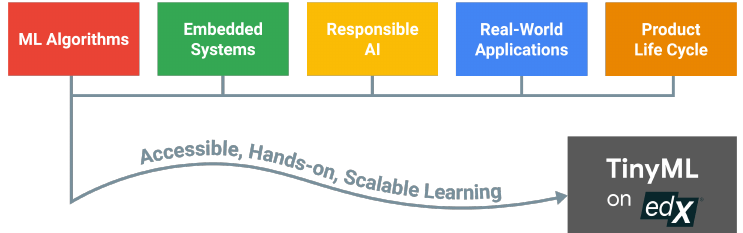
Figure 1. We designed a new applied-ML course. The course is motivated by real- world applications, covering not only the software (algorithms) and hardware (embedded systems) but also the product life cycle and responsible AI considerations needed to deploy these applications. To make it globally accessible and scalable, we focused on the emerging TinyML domain and released the course as a MOOC on